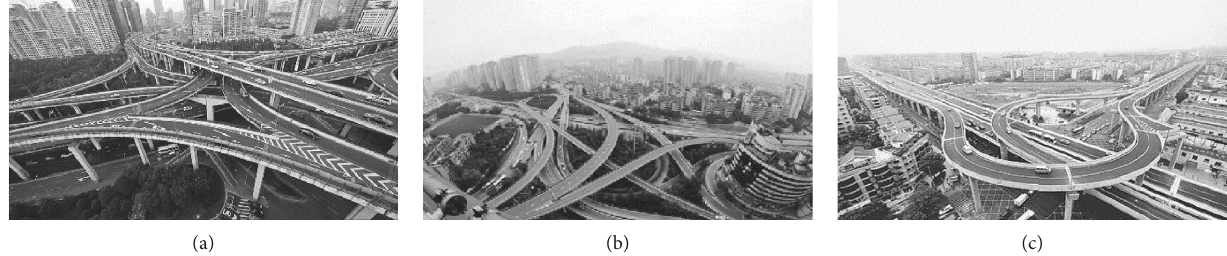
Figure 4: The nature representation of small-world networks in urban traffic networks (source: maps of Shanghai, Chongqing, and